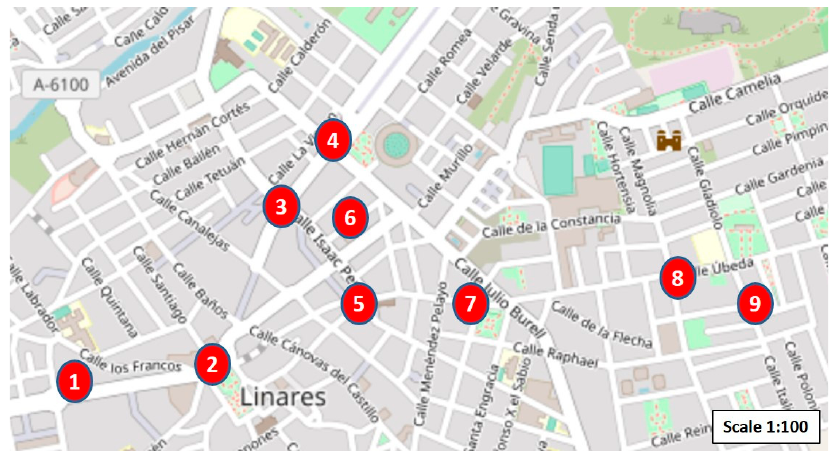
Figure 1. The critical locations identified for the measurement of acoustic noise in the city of Linares (Jaén).